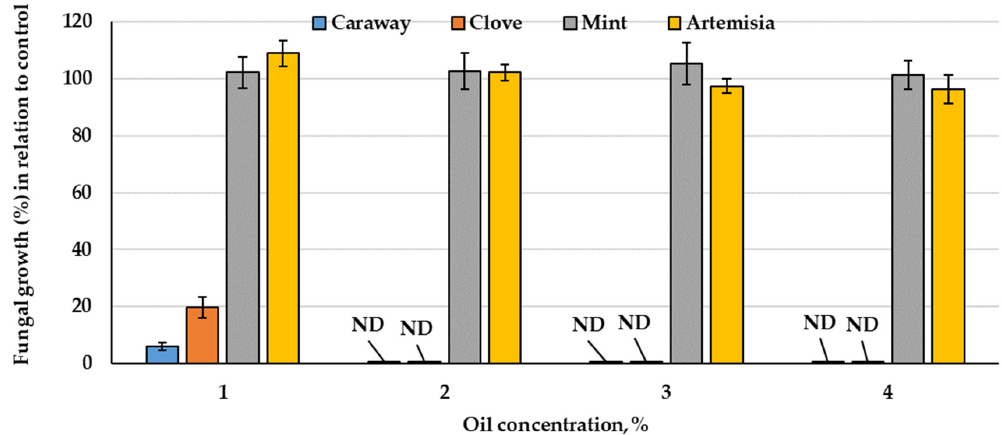
Figure 7. The growth of P. polonicum (%) as a response to various essential oils concentrations, in relation to control. ND: not determined due to the absence of fungal growth.